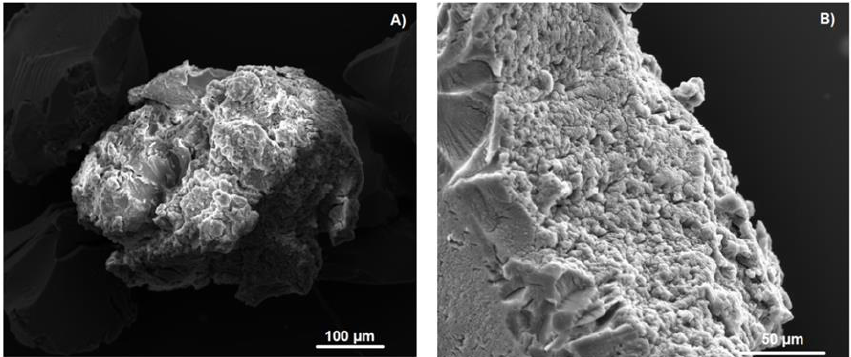
Figure 12. SEM images of magnetic NSs after a repeated number of cycles ( A , B ).